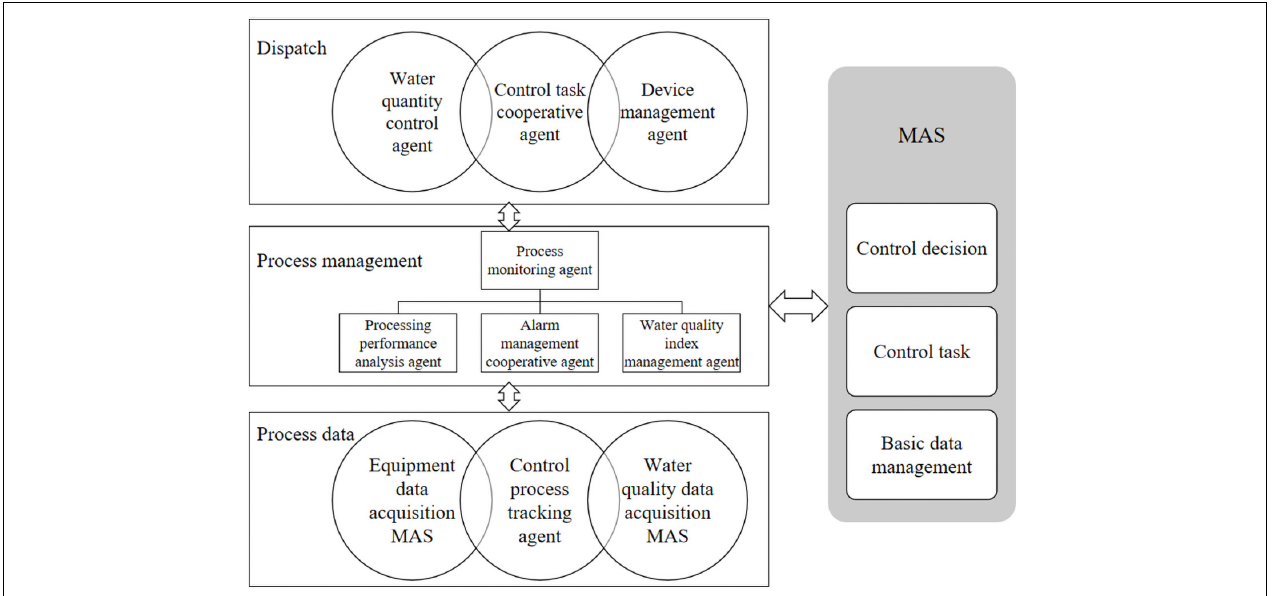
FIGURE 1 | Mobile Agent Server (MAS) structure of distributed control